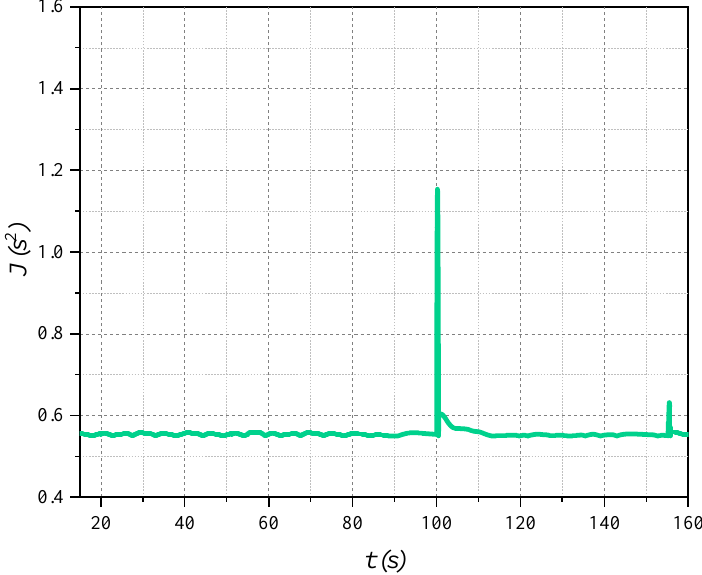
Figure 21. DC-link voltages statistics of DER 1 for different scenarios.